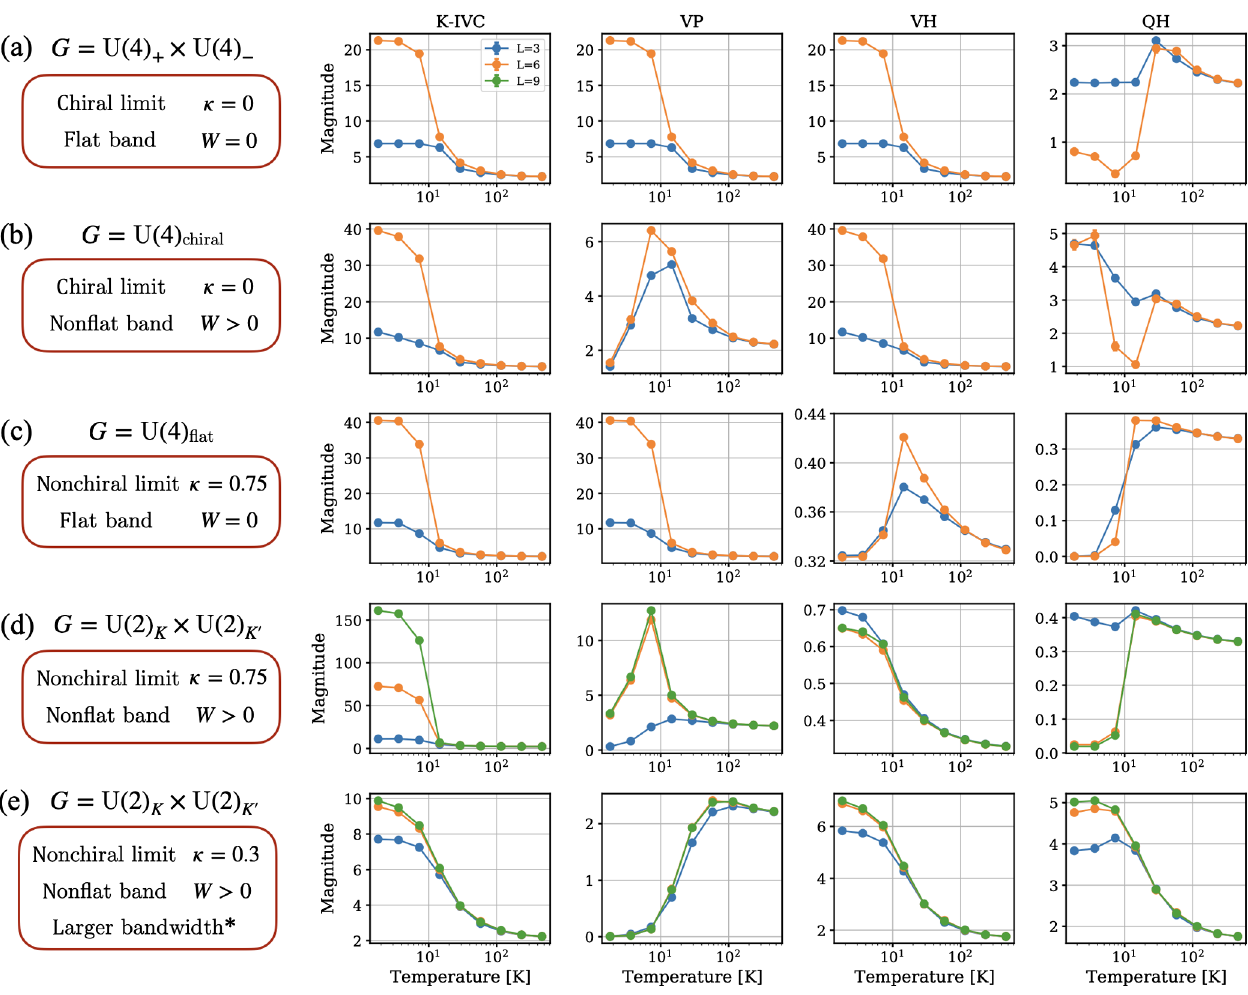
FIG. 2. Correlation functions at q ¼ 0 and global symmetry G of full-interacting TBG Hamiltonians in four different limits ( ϵ ¼ 10 20 nm). Each limit is characterized by ð κ ; W Þ , where κ ¼ w and d s ¼ (a) Chiral, flat limit: (0,0 meV). (b) Chiral, nonflat with artificially reduced bandwidth: (0,3.8 meV). (c) Nonchiral, flat: (0.75,0 meV). (d) Nonchiral, nonflat: (0.75,8.3 meV). (e) Nonchiral, nonflat: (0.3,14.3 meV). Correlation functions S